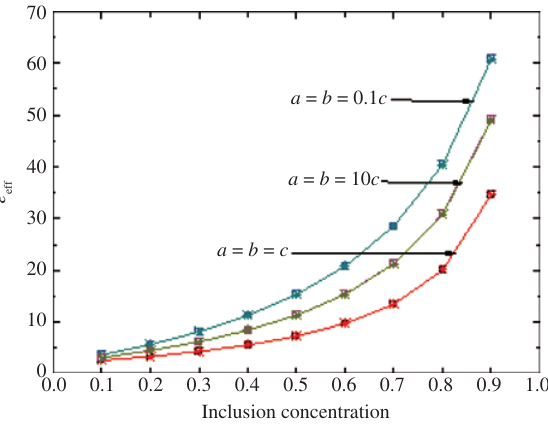
Figure 8: The effective permittivity of mixtures with bilayer ellip- soids oriented randomly calculated by the SCA method (□) and the method developed by Jones and Friedman ( *